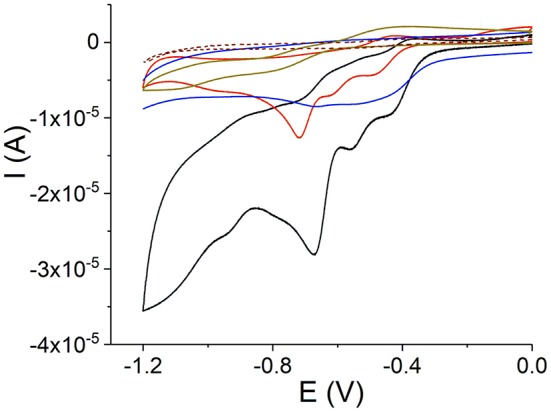
Cyclic voltammograms on a GCE: Sn(IV)TPyP4+ at pH 2 (black line) and 3.5 (red line), H2TPPS44- at pH 6.9 (dark yellow line), H4TPPS42- and aggregates at pH 4 (brown dashed line), and H4TPPS42--Sn(IV)TPyP4+ adsorbed overnight (blue line), 0.1 M KNO3, scan rate 50 mV s−1.